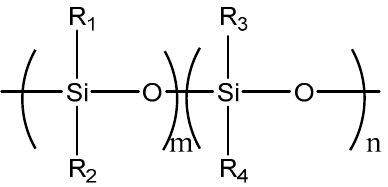
Figure 1. Molecular formula of silicone rubber material.